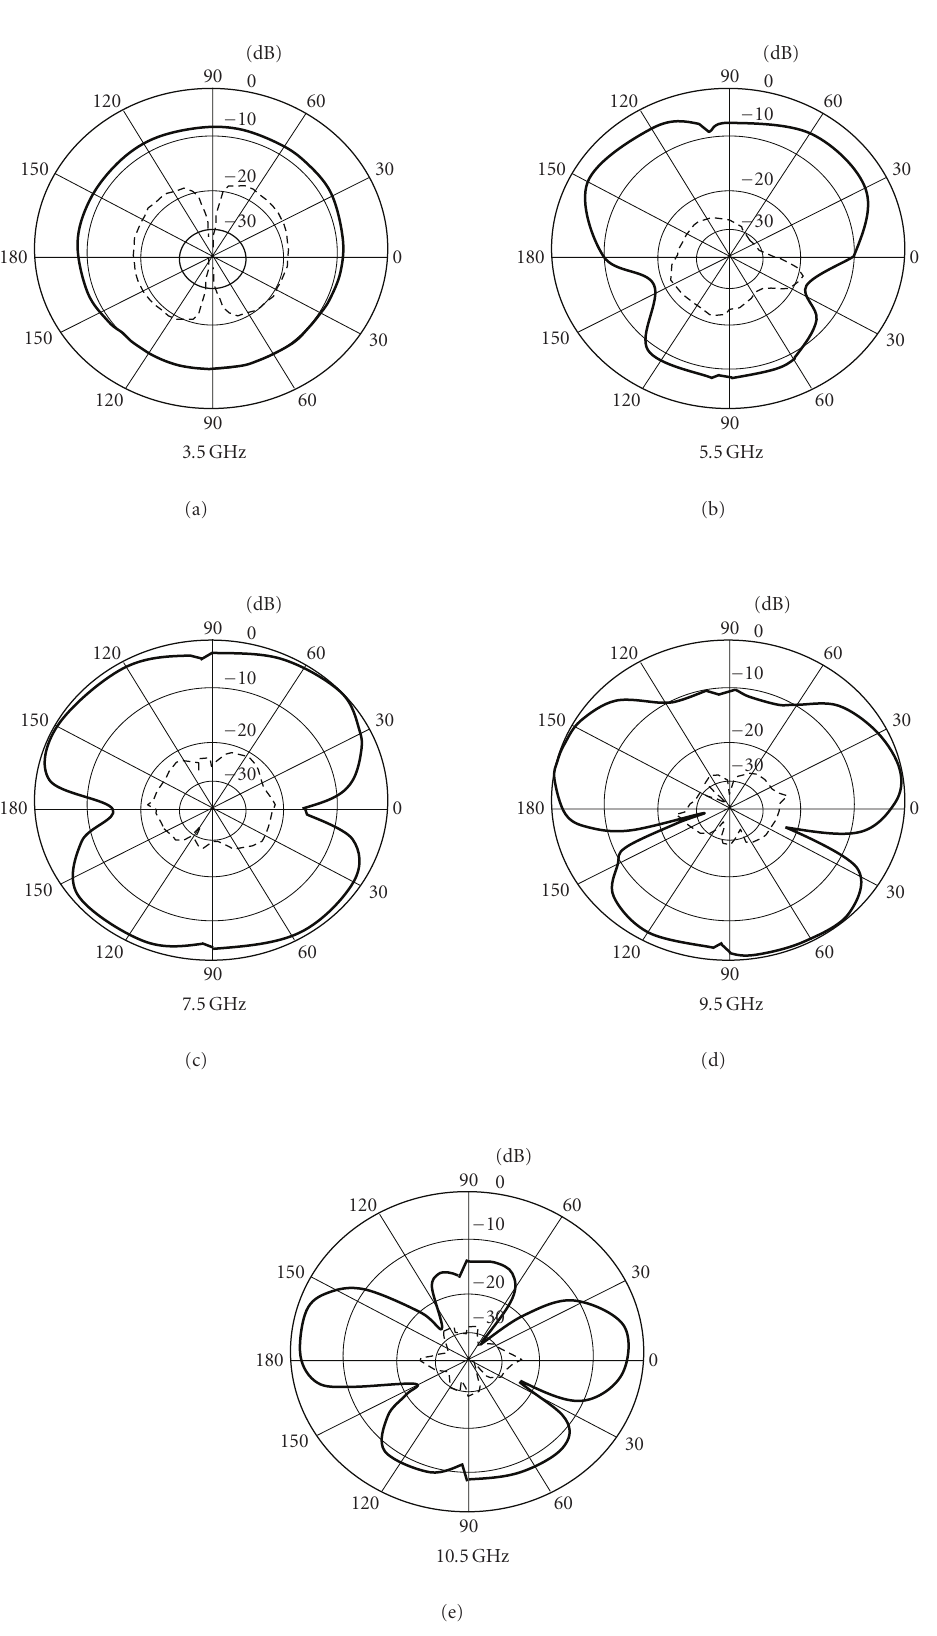
Figure 8: Measured radiation pattern of cross-slot antenna in H-plane ( ϕ = 0 ◦ ). The solid line is copolar and the dash line is cross-polar